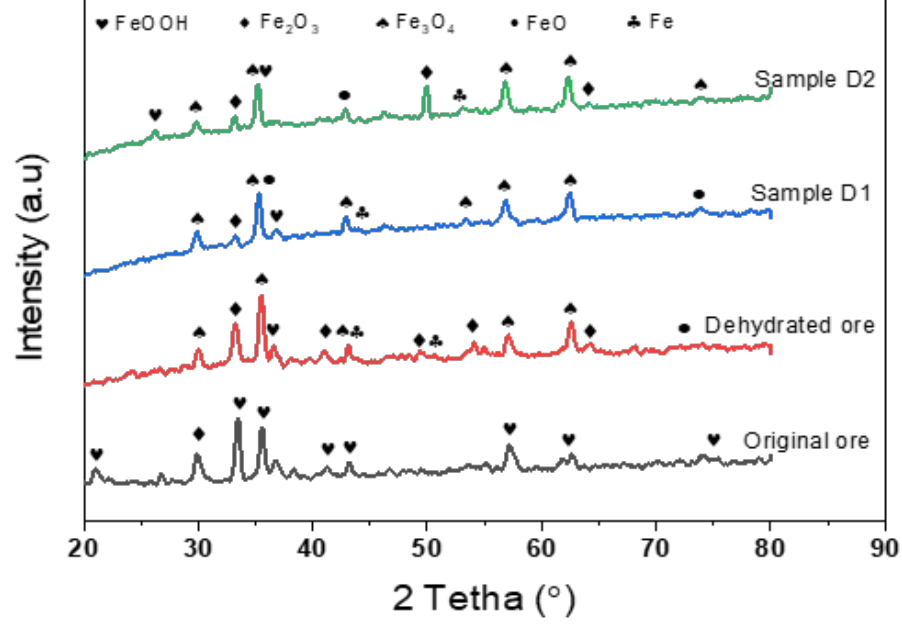
Figure 7. XRD (X-ray diffractometry) pattern of samples before and after the carbonization process at 500 °C for 1 h.